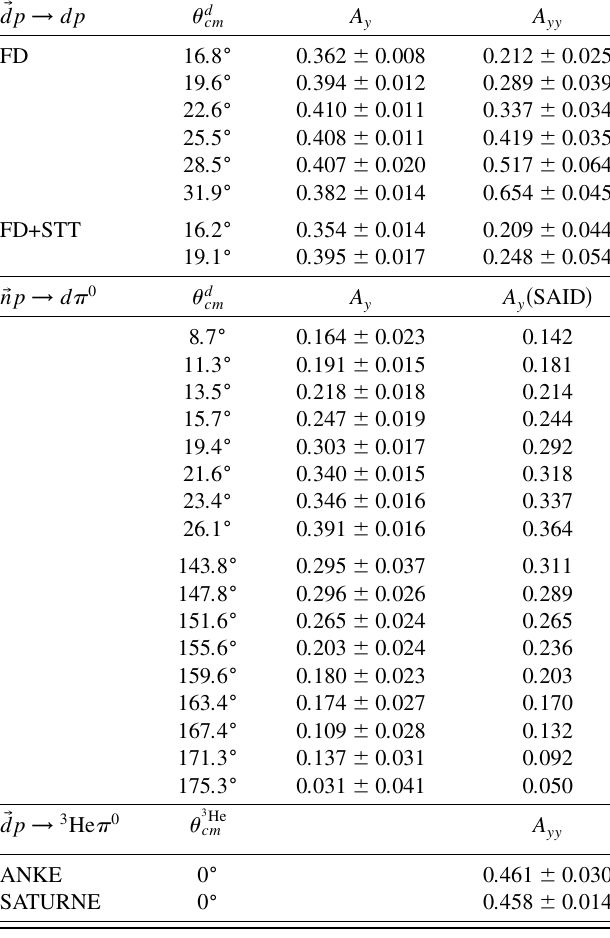
TABLE II. Analyzing powers A and A of the ~dp ! dp y yy (top, using only the FD, or a reaction as function of (cid:3) d cm of the ~np ! coincidence of FD and STT), analyzing power A y d(cid:1) 0 reaction as function of (cid:3) d (middle), and the values of the cm analyzing power A of the ~dp ! 3 He (cid:1) 0 reaction at (cid:3) 3 He cm (cid:7) 0 (cid:4) yy from ANKE and SATURNE [36] (bottom). Also shown are the (cid:1) ~pp ! d(cid:1) (cid:5) (cid:2) obtained using the SP96 SAID predictions for A y solution [39].